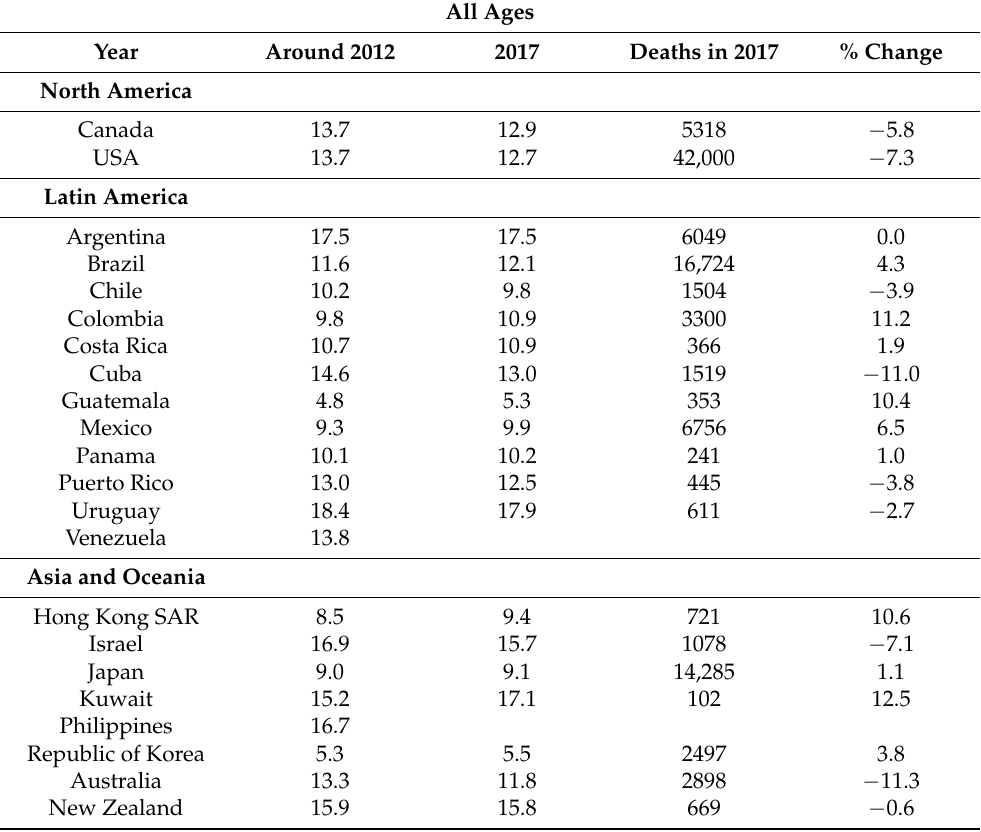
a Including 14 countries from the Americas and other 8 countries from Asia and Oceania, with over 1 million female inhabitants and mortality data coverage of over 90%, except for Guatemala (88%) and Brazil (87%). b Last available year for Kuwait is 2015. Figure 1 ranks the mortality rates observed in 2017. In 2017, the highest mortality rates were observed in Uruguay (17.9/100,000 women), Argentina (17.5), the Philippines (17.3), and Kuwait (17.1). The lowest rates were reported in Guatemala (5.3/100,000 women), Korea (5.5), Japan (9.1), and Hong Kong